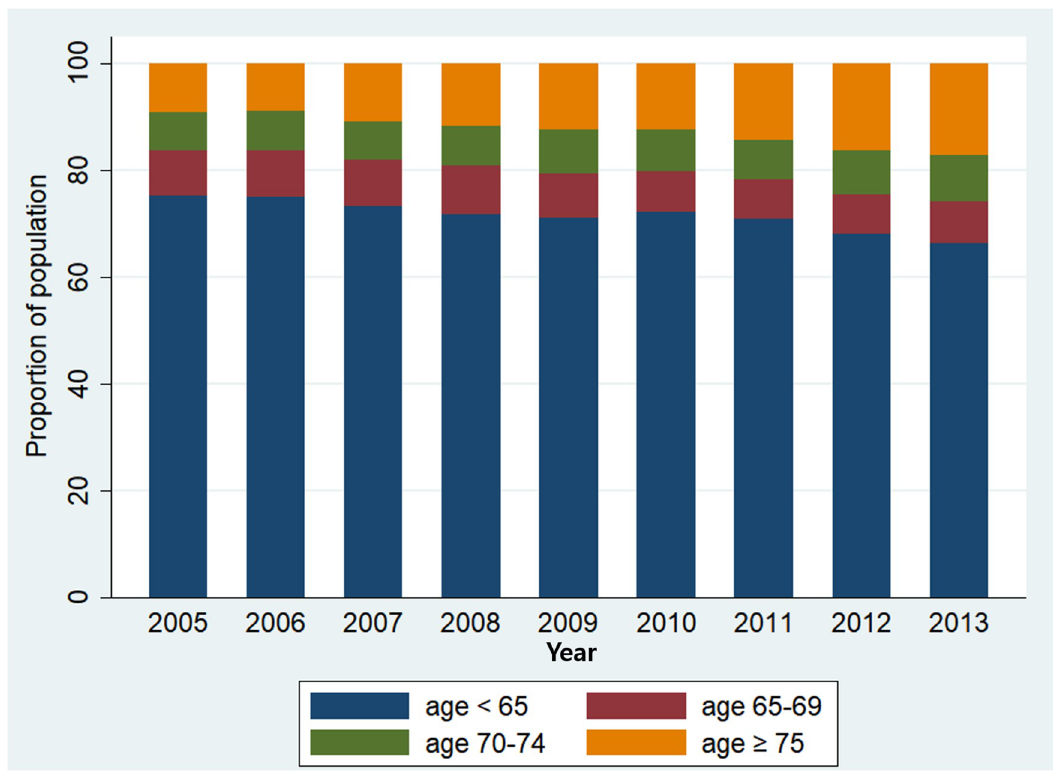
Fig 1. Annual age distribution of CAP patients in NHIS-NSC